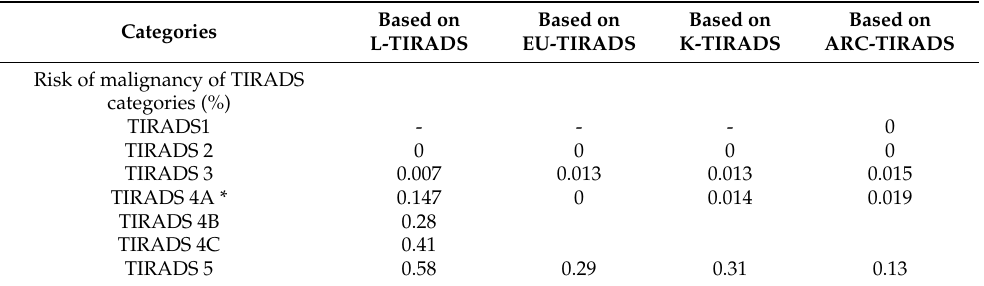
Table 6. Comparison between risk of malignancy (%) of L-TIRADS, EU-TIRADS, K-TIRADS, and ACR-TIRADS categories.